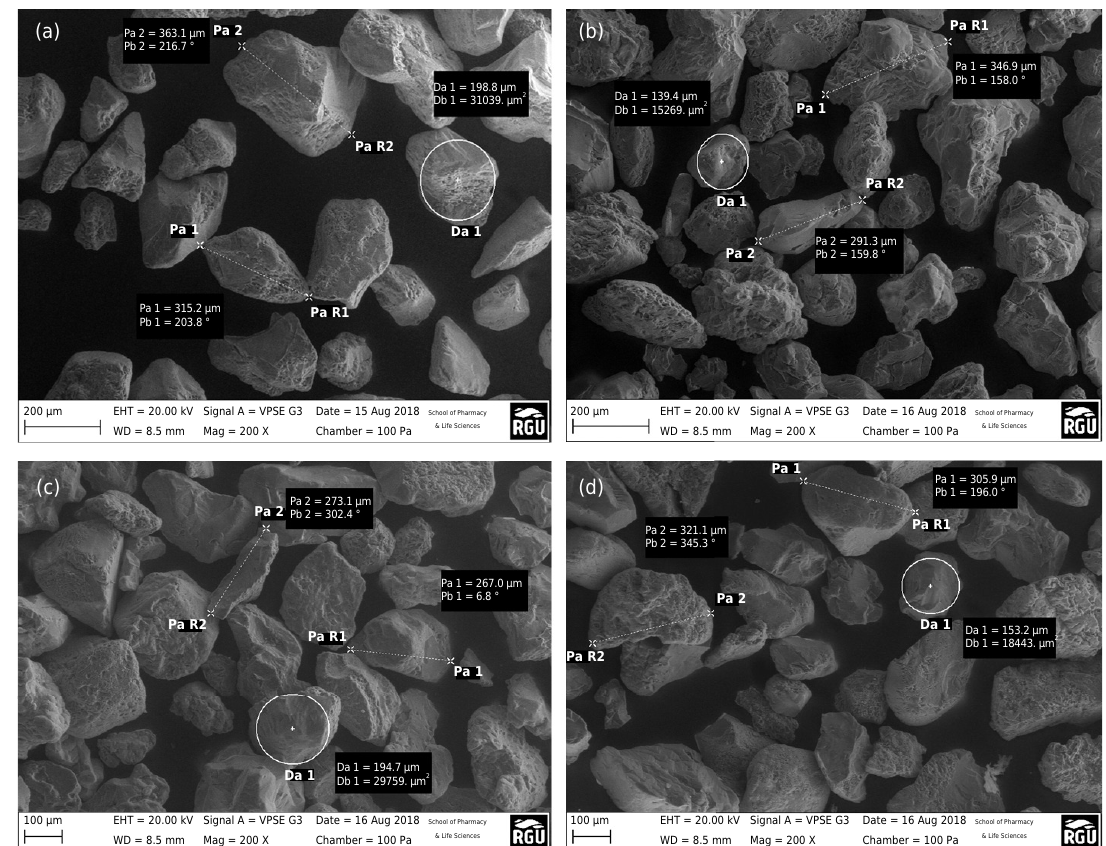
Figure 4. Representative examples of particles of the finer sand fraction (<0.25 mm) measured by SEM: a) sample 3: area 1; b) sample 7: area 2; c) sample 15: area 3; d) sample 19: area 4. Note: a complete identification of the samples is presented in table